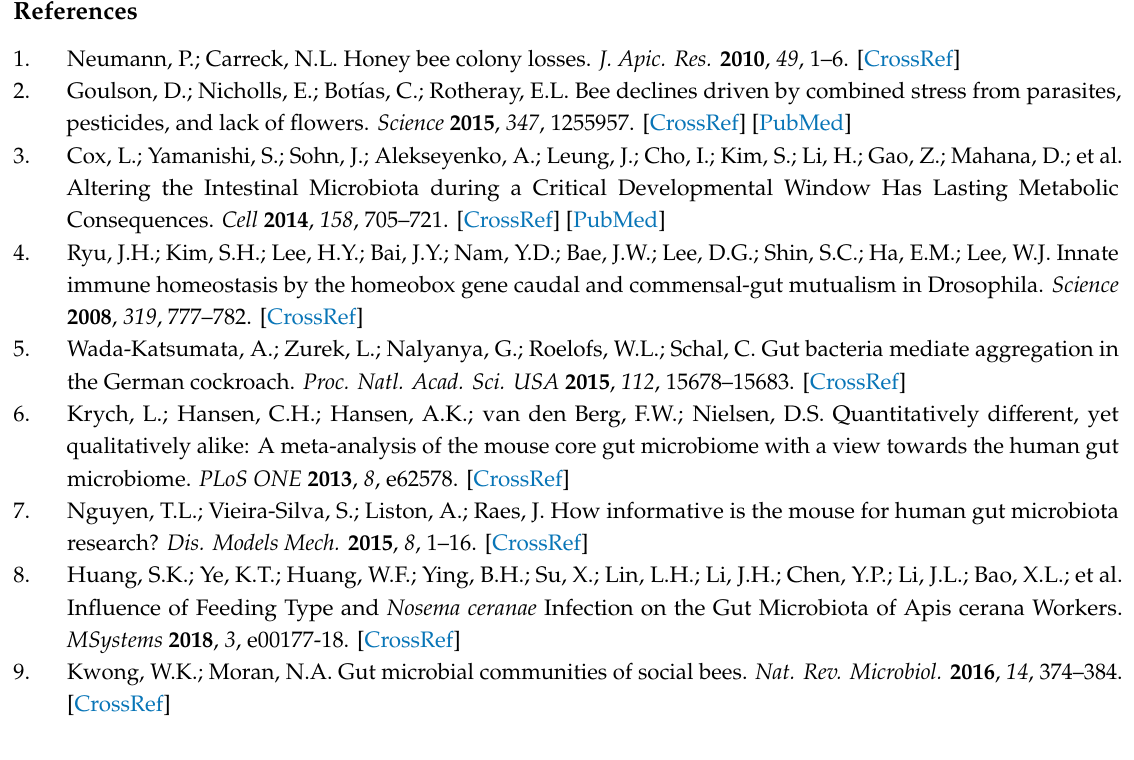
Figure S1: The proportion graph of total bacterial phylum (1a) and genera (1b). Figure S2: The proportion of total fungal phylum (2a) and genera (2b). Figure S3: The bacterial (3a) and fungal (3b) taxon impacted on communities associated with corbicular pollen (P) and hive storage bee bread (B) via LDA scores. Figure S4: The bacterial (4a) and fungal (4b) taxon impacted on communities associated with corbicular pollen (P) and hive storage bee bread (B) via LDA scores (4a). Figure S5: Phylogenetic tree based on the neighbor-joining tree of fungal (5a,b,c) and bacterial isolates (5d) from all samples. Figure S6: The example of bioactivity screening from fungal isolates. Table S1: pH measuring (Significant di ff erence between treatments with One-way ANOVA). Table S2: Colony-forming unit / gram (Significant di ff erence between treatments with One-way ANOVA). Table S3: Number of OTUs. Table S4: Diversity indices. Table S5: Significant di ff erence between the number of dominant OTUs from 16s RNA genes; Significant di ff erence between the number of dominant OTUs from ITS genes. Table S6: Number of gene prediction groups and significant di ff erence between corbicular pollen and hive-stored bee bread. Table S7: Isolation and characterization of filamentous fungi associated with corbicular pollen and hive storage bee bread. Table S8: Isolation and characterization of bacteria associated with corbicular pollen and hive storage bee bread. Table S9: Positive antagonistic of filamentous fungal supernatant to bacterial